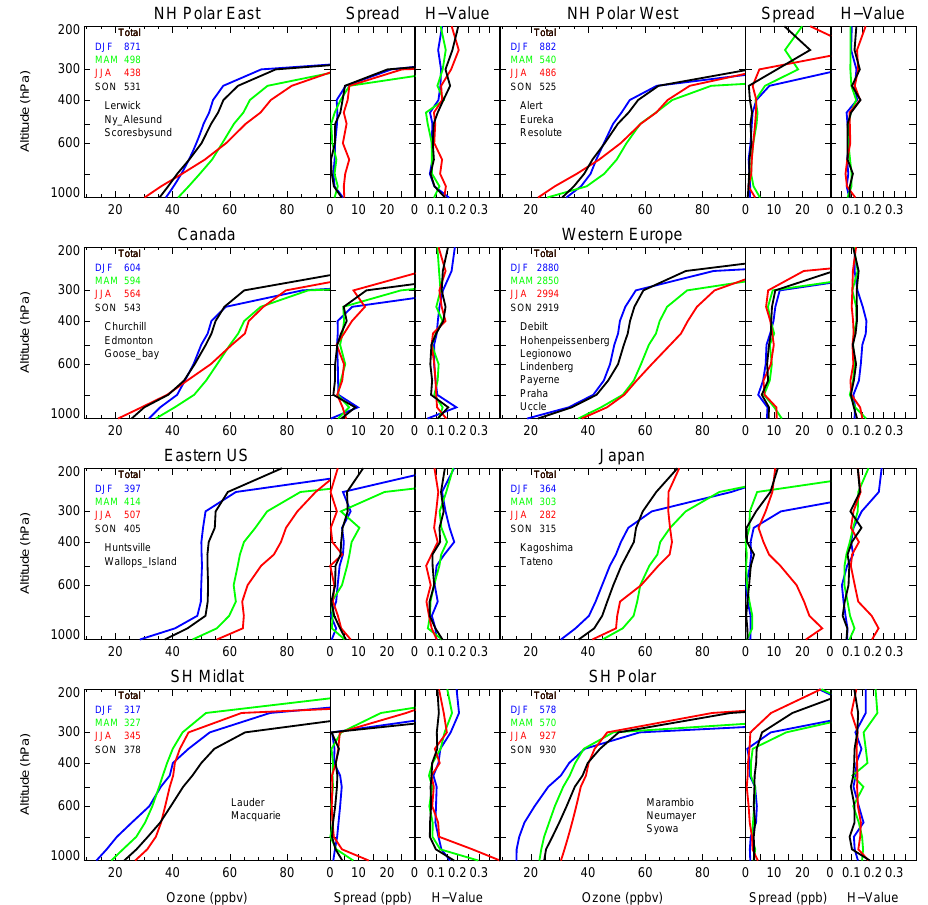
Fig. 2. Altitude distributions (median) of ozone soundings averaged for different seasons (colors) and regions between 1995 and 2011 for the tropophere. The total number of profiles used for each season and region is shown on the top left of each panel. The stations entering the profiles are listed in the panel. The spread of median ozone values from individual stations and the averaged Hellinger distance between each station and the regional aggregate are illustrated in the two sub-plots on the right of each